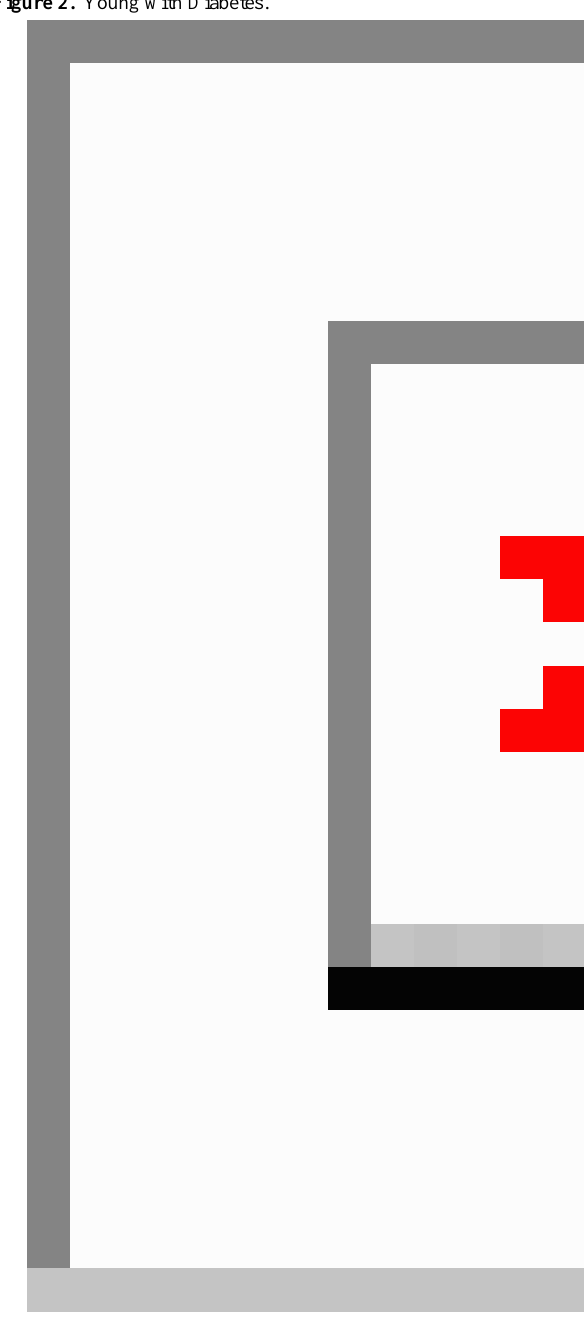
Figure 2. Young with